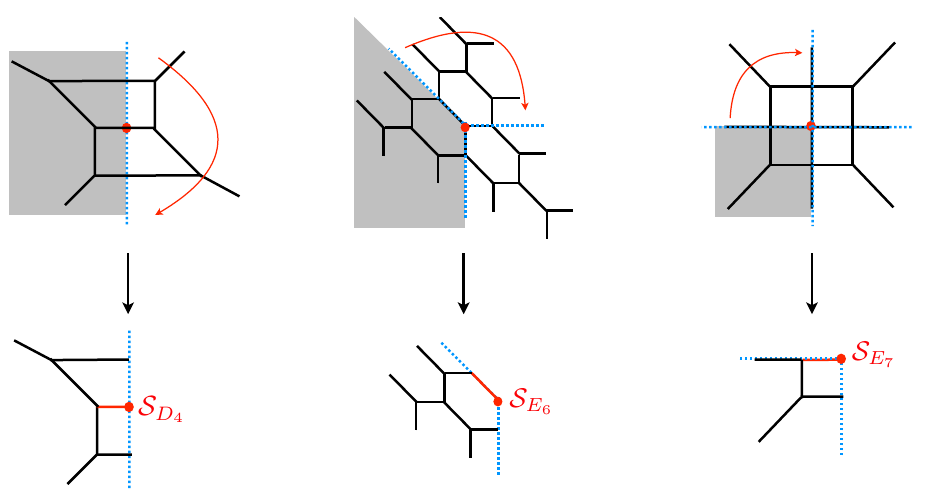
Figure 18 . The prescriptions for the Z 2 , Z 3 , Z 4 S-folds (from left to right). After the Z n quotients, the brane webs reduce to the bottom three diagrams. The red line in the bottom diagrams denotes the 5-brane ending on one of extra 7-branes at the